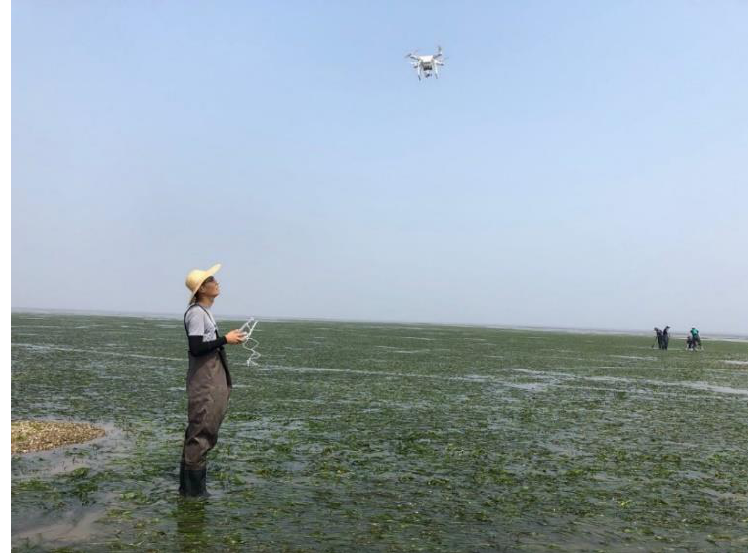
Figure 3. Field photo of a seagrass bed at the study site in the Bohai Sea (Photo by Xiaomei Zhang; tide height of 0.73 m on 8 June 2019, acquired at Shaleitien Tao Station using wxtide47 software). The two visible bands (green and red) and the near-infrared band were used to ana- lyze the Landsat images. In addition, wedge-shaped gaps in some Landsat 7ETM+ images were filled [43]. Geometric and radiometric corrections were applied using ENVI 5.2 im-